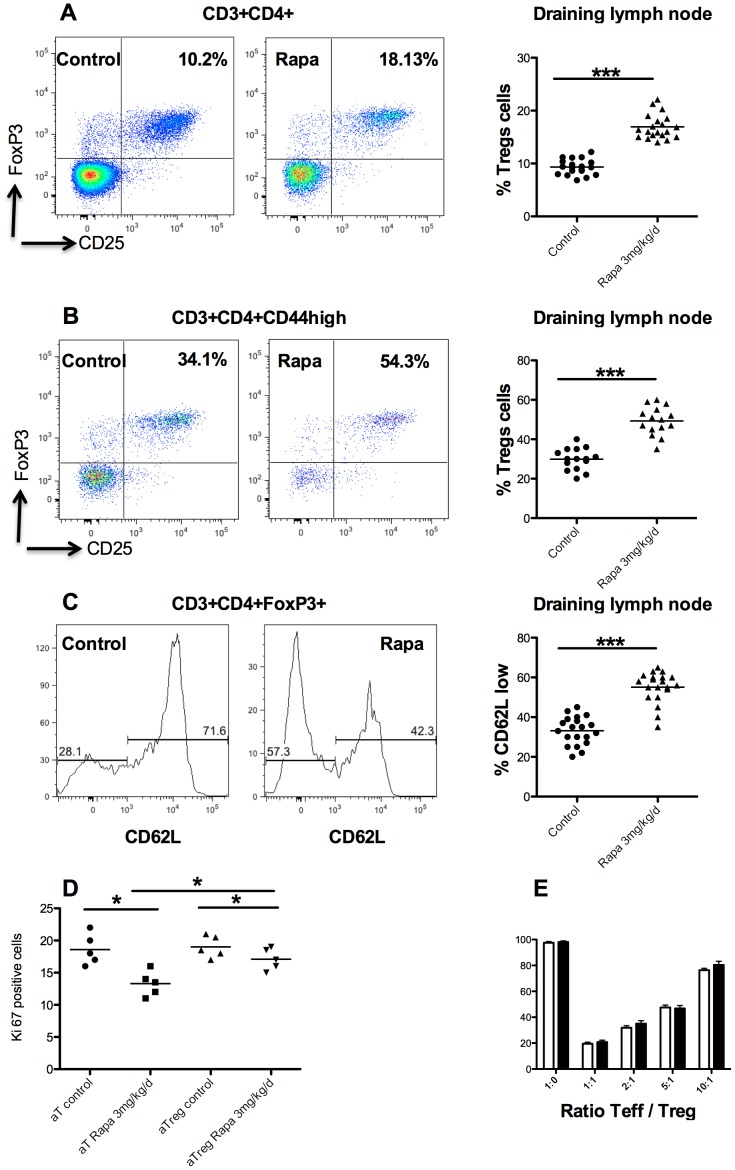
Effect of rapamycin on Treg cells.Representative dot plot of flow cytometry analysis of draining lymph nodes for percent of Treg (CD4+CD25+FoxP3+) in CD4+ (A) and in CD4+CD44high (B) in controls and rapamycin (3 mg/kg/day) treated mice. Percent of Treg (CD4+CD25+FoxP3+) in CD4+ (A, right) and in CD4+CD44high (B, right) in controls and rapamycin (3 mg/kg/day) treated mice. C: Histogram representative of the difference in activation of Treg (CD62Llow cell) and naive Treg (CD62Lhigh) in controls and rapamycin (3 mg/kg/day) treated mice. D: Suppressive test. Horizontal lines indicate means. Suppressive activity of sorted CD4+CD25+ T cells (Treg) from controls (white bars) and rapamycin (3 mg/kg/day, black bars) mice on the proliferation of autologous CD4+CD25− T cells (responders) stimulated with irradiated (15 Gy) splenocytes. Proliferation of responder cells (Teff) was measured by 3H-Tymidine incorporation (counts per minute, cpm). Results are indicated as percentage inhibition (±SD) compared to a max (ratio 1∶0). Different Teff∶Treg ratios were tested. E: Percent of Ki-67positive cells (i.e. proliferative cells) in activated effector (aT) and activated regulatory (aTreg) T cells in controls and rapamycin (3 mg/kg/day) treated mice.